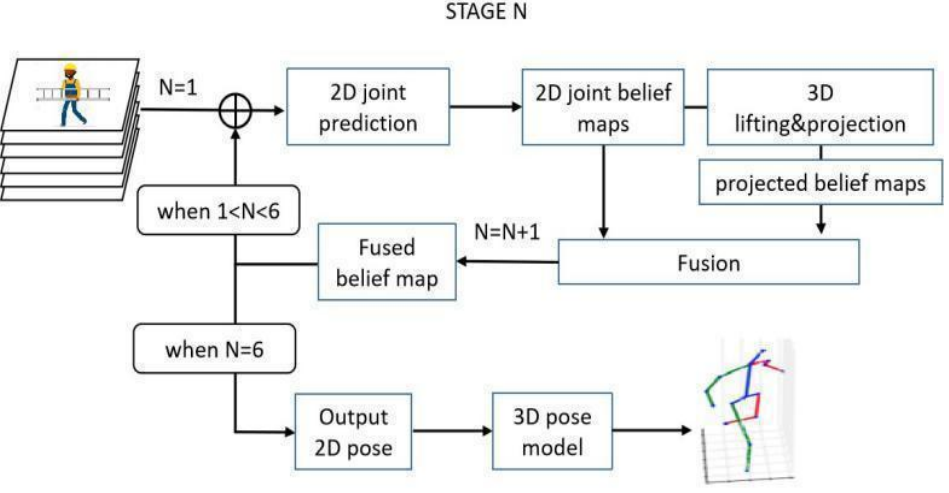
Figure 6. The structure of the 3D pose estimation model. Inspired both by the approach [87] that represents the space of human poses as a mixture of Principal Components Analysis (PCA) and the idea that identifies poses as